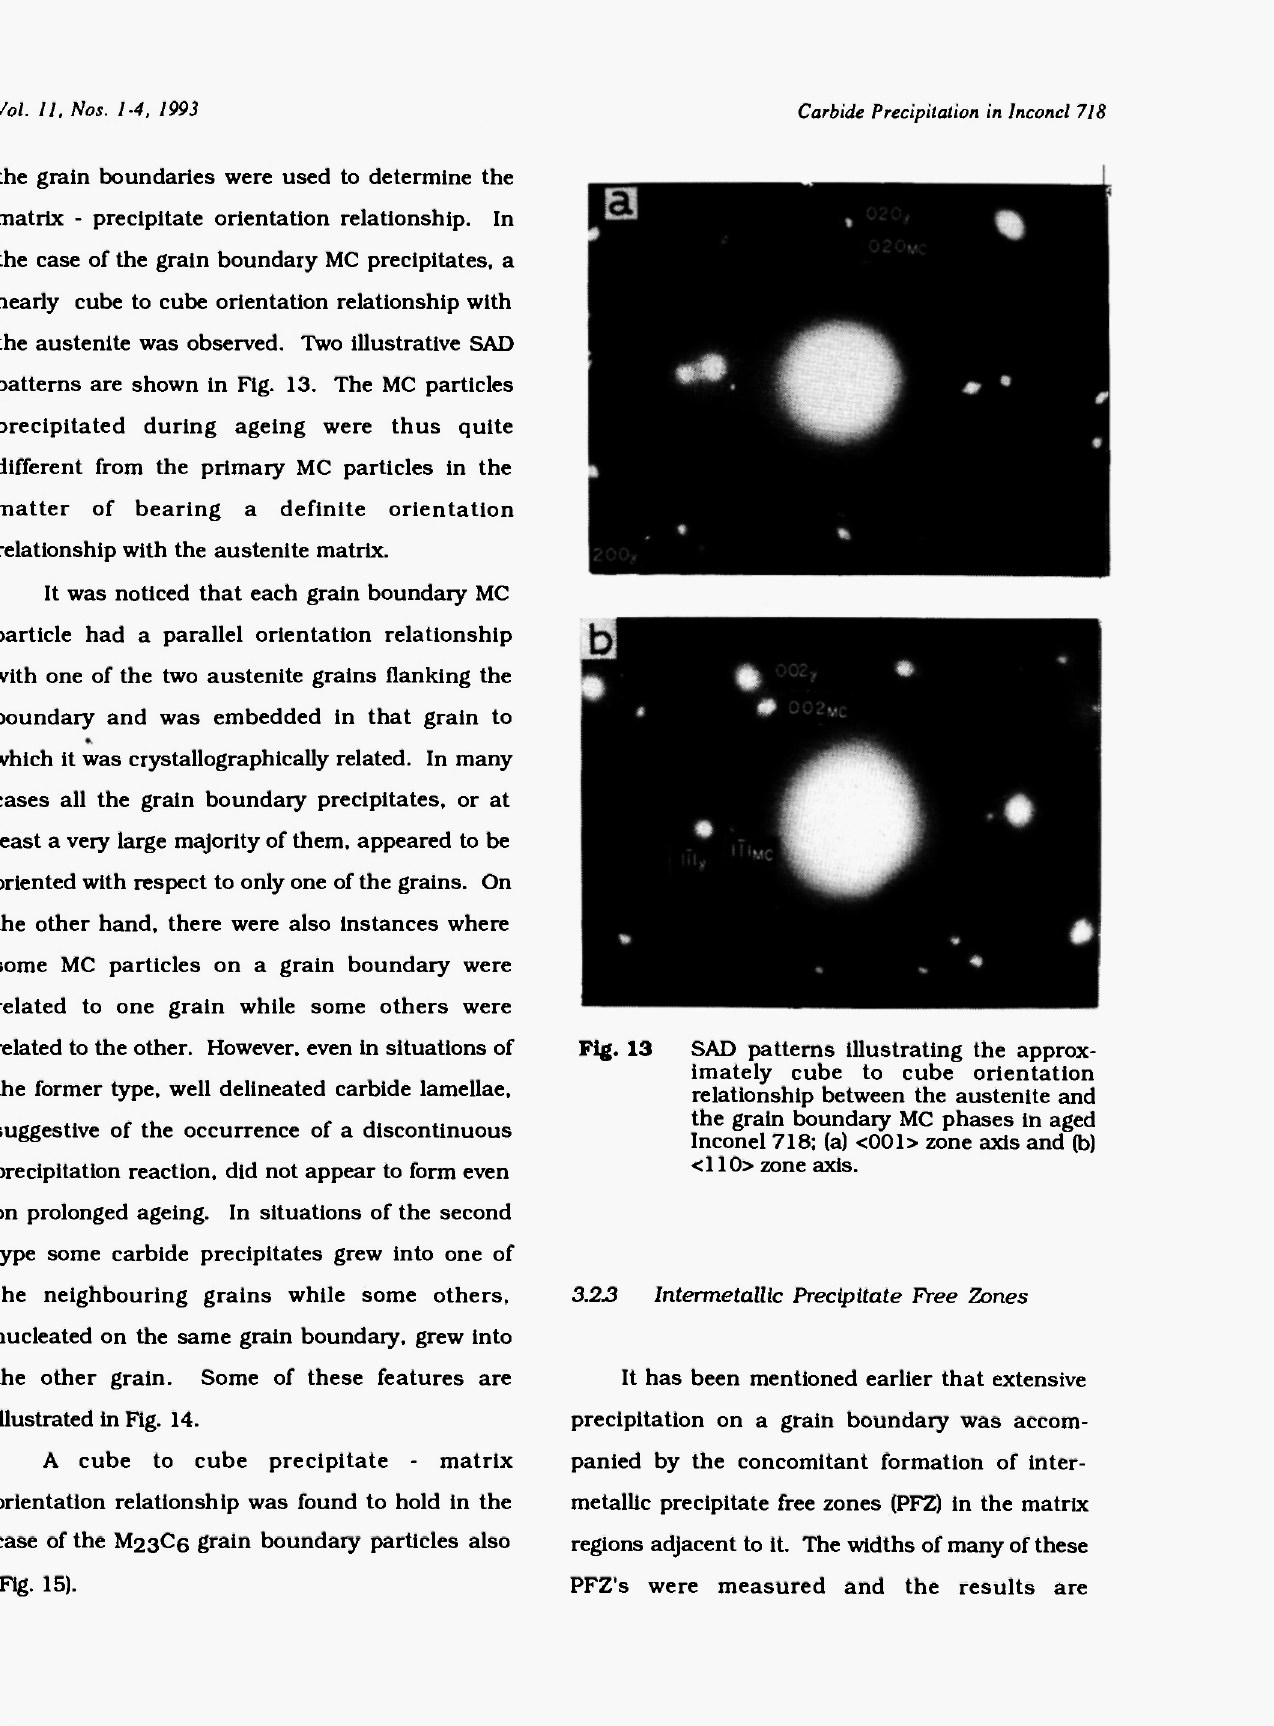
SAD patterns illustrating the approx- imately cube to cube orientation relationship between the austenite and the grain boundary MC phases in aged Inconel 718; (a) <001> zone axis and (b) <110> zone